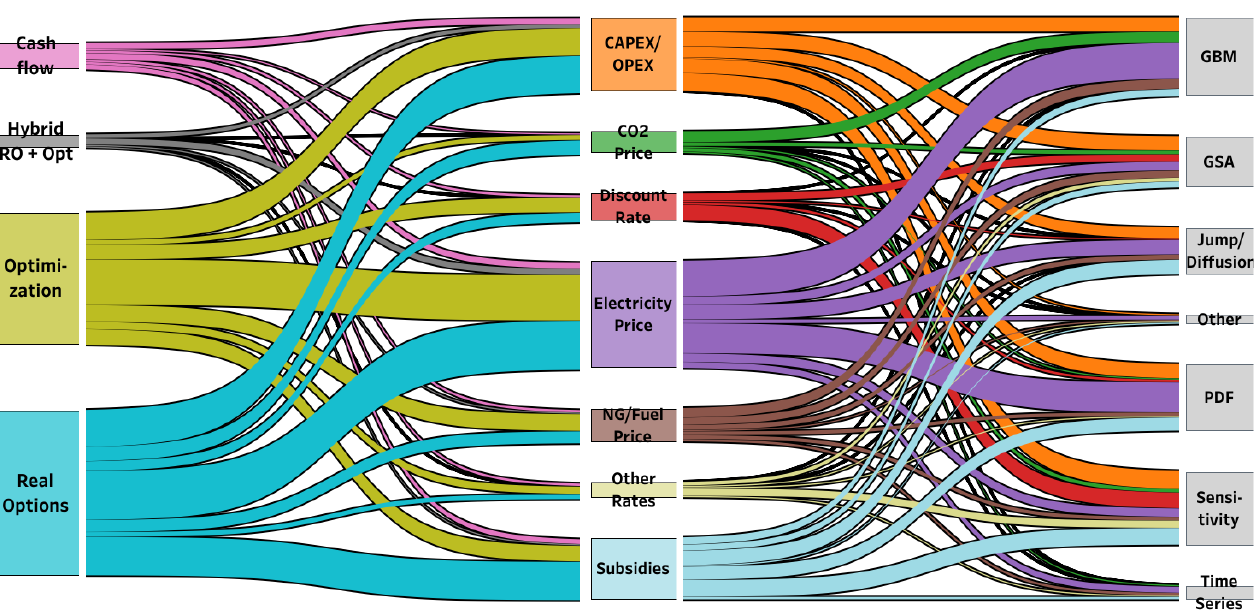
Figure 9. Multi-level Sankey flowchart of problem formulations (left) to SoUs (middle) to UCMs (right). The total flow represents the number of SoUs analyzed. One article can deal with more than one SoU, and each SoU is characterized by one of the UCM. Self-elaboration based on [159].